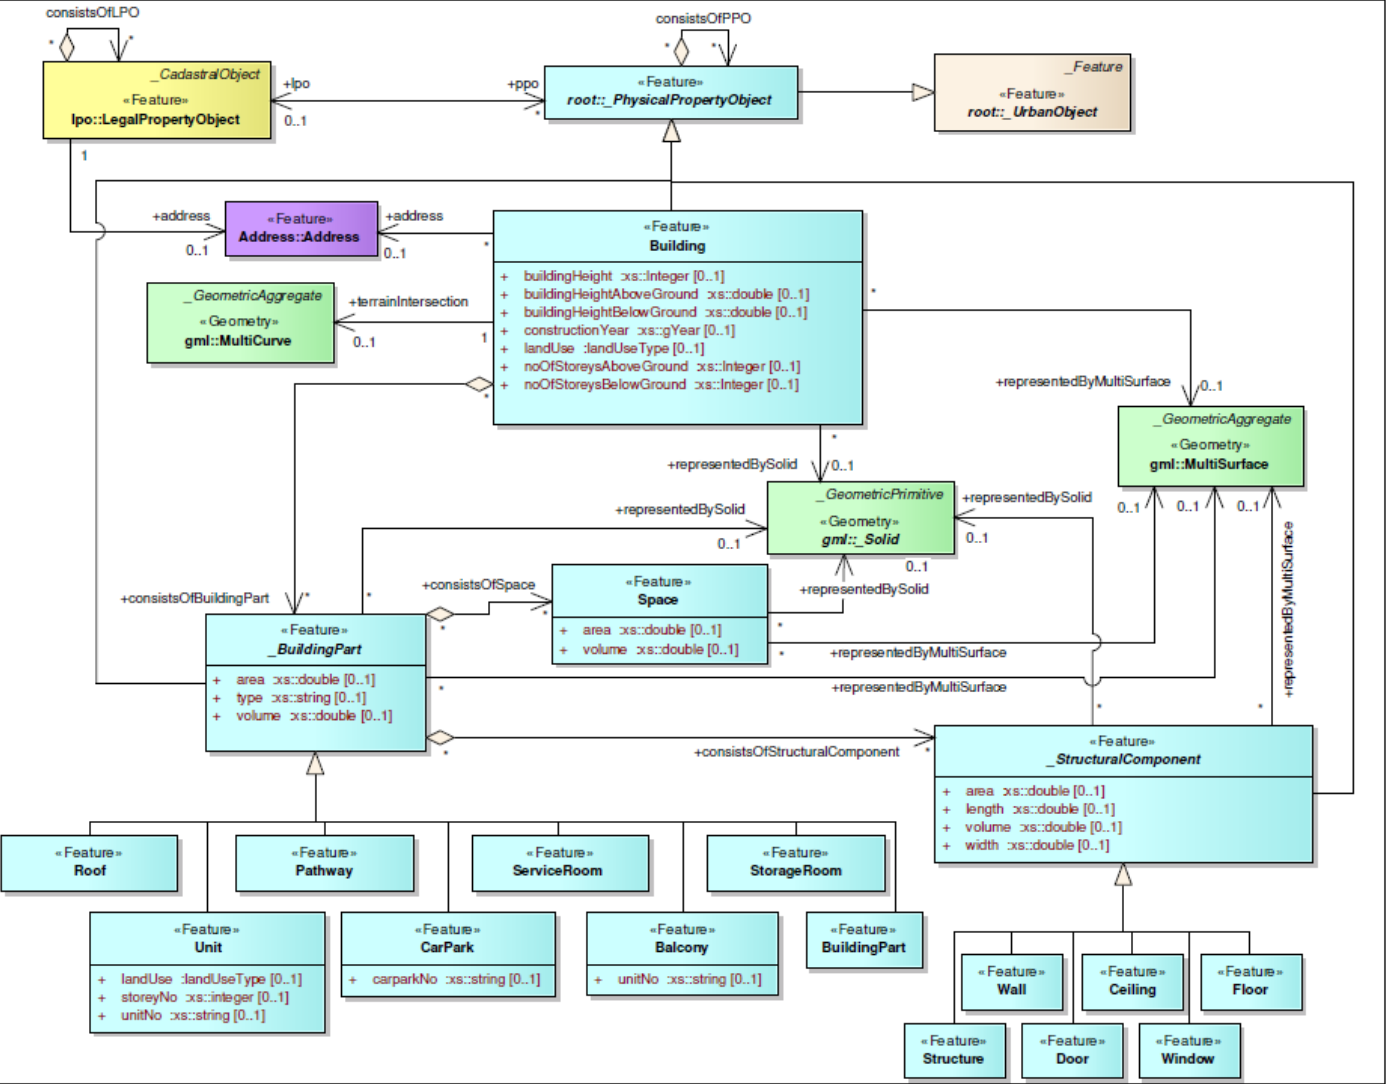
Figure 17. The UML diagram of 3DCDM Building